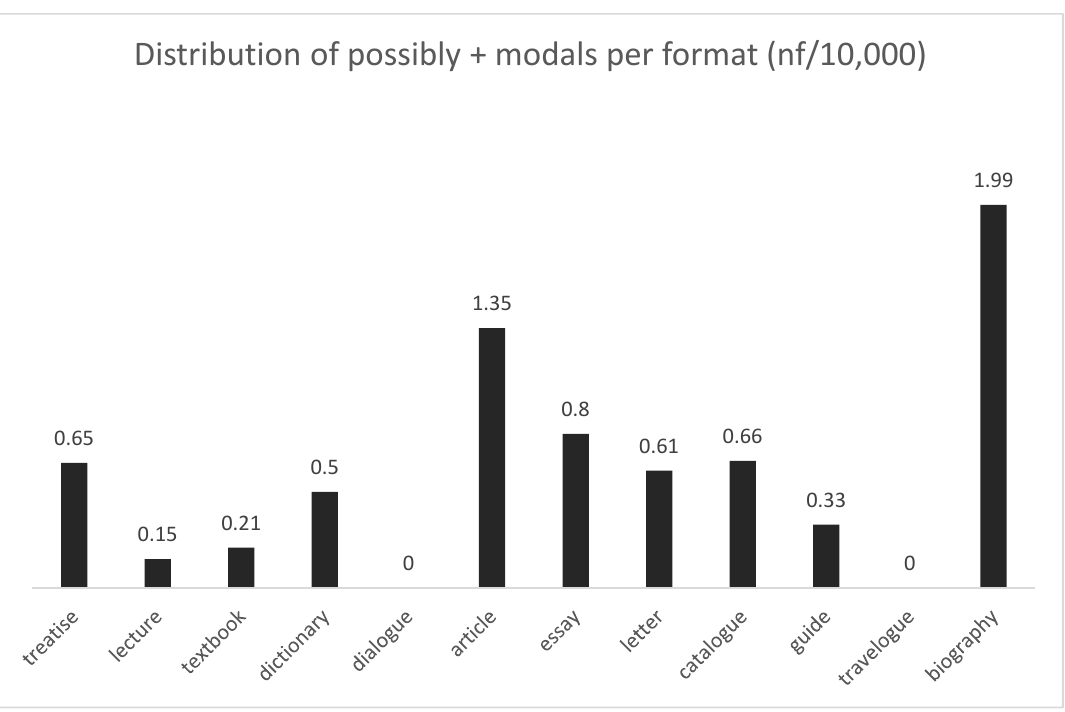
Figure 6. Use of perhaps with modals per sex.